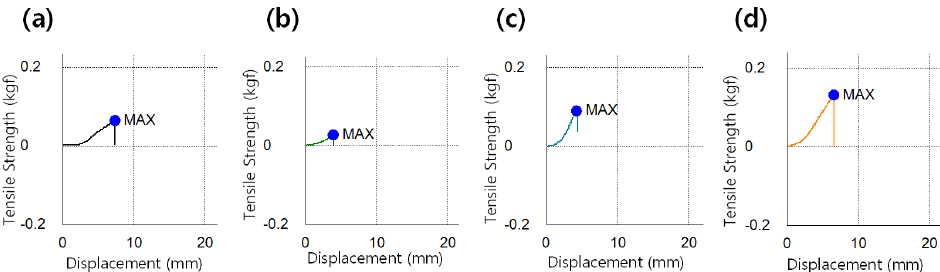
Figure 6. Tensile strength image of ( a ) Ref sample, ( b ) M0.05N5 sample, ( c ) M0.1N5 sample, and ( d ) M0.1N5S1 sample.